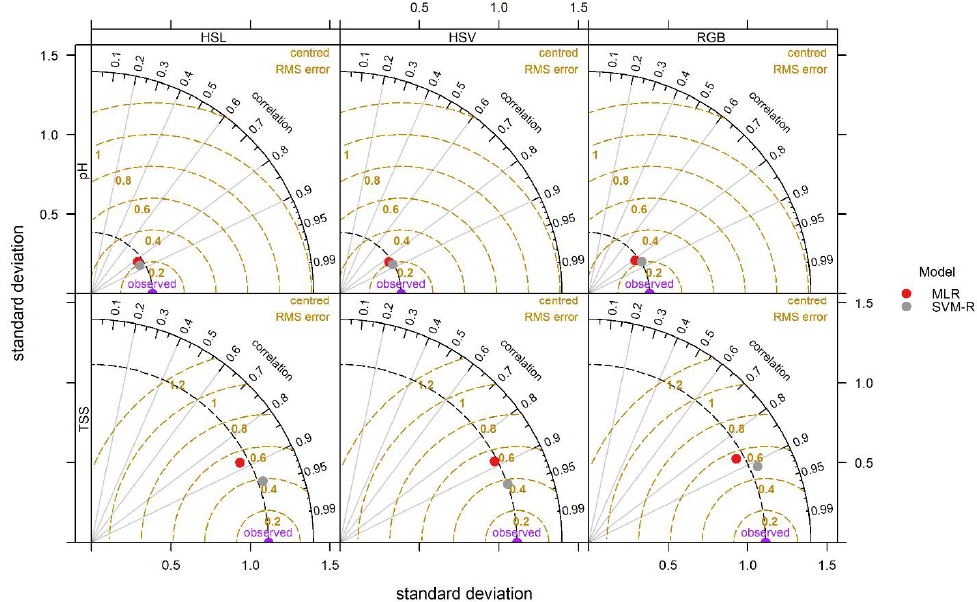
Figure 10. Taylor diagram of testing results of MLR and SVM-R models with RGB, HSV and HSL datasets for TSS and pH prediction.